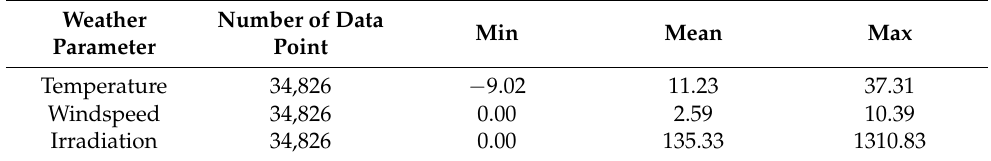
Figure 8. Local weather data sample. Table 5. Statistical descriptive of local weather data.